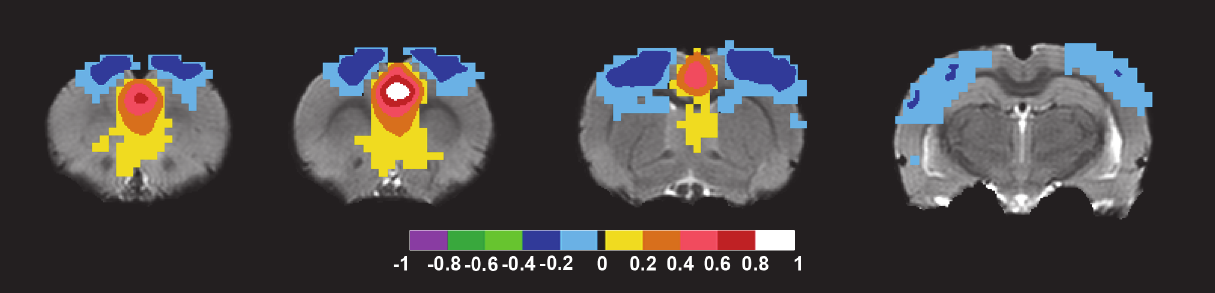
Fig 2. Rat Default Mode Network. When the bilateral seed was placed in the Rostral Anterior Cingulate Cortex approximately Bregma in mm: +/-0.5; 2.5; 1.7 the DMN was distinguished. Axial rat brain images are sorted from left to right in rostral to caudal order. The image to the far left shows positive color-coded FC-values in pre limbic cortex, infra limbic cortex, orbital cortex and cingulate cortex. The two middle images show positive FC-values in cingulate cortex, septal nuclei. Also, note the bilateral anticorrelated color-coded regions in the motor-sensory cortical region throughout the images. Note the lack of signal in hippocampus. FC-values are displayed with a pseudo-colored scale bar; with increments of 0.2 each designated a color (see the color-bar in the image).